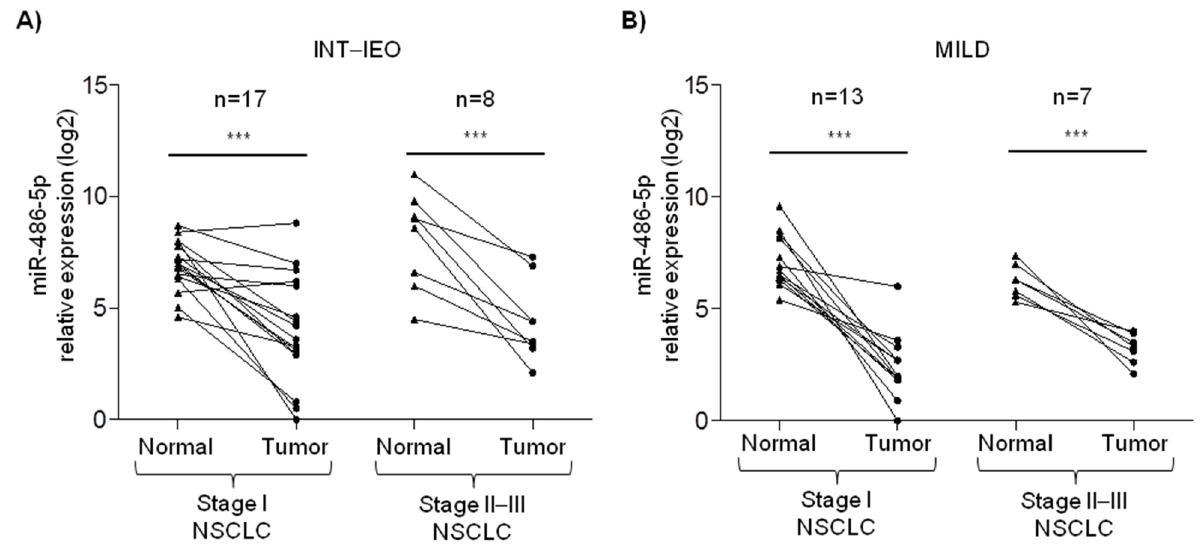
Figure 1. miR-486-5p expression in paired normal and lung tumor tissue. RT-qPCR analysis of miR-486-5p relative expression normal lung and paired tumor tissue samples collected from stage I and stage II–III lung cancer patients identified during ( A ) the Istituto Nazionale dei Tumori–Istituto Europeo di Oncologia (INT–IEO) and ( B ) the Multicentre Italian Lung Detection (MILD) lung cancer screening trials. Asterisks represent the level of significance by paired t -test p -value (***